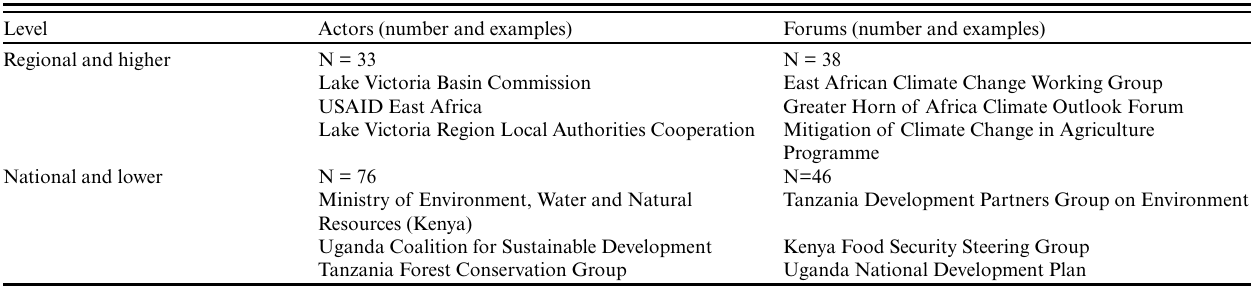
Table 1 . Cross-tabulation and examples of actors and forums operating at different levels within the Lake Victoria region climate change adaptation governance